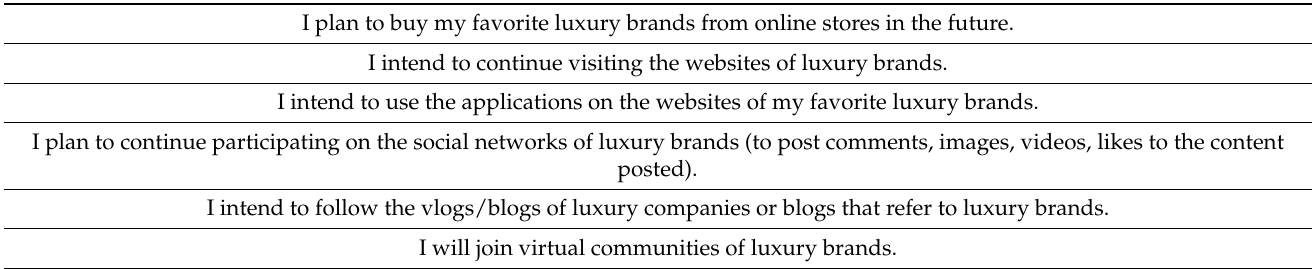
Table A4. The consumer engagement